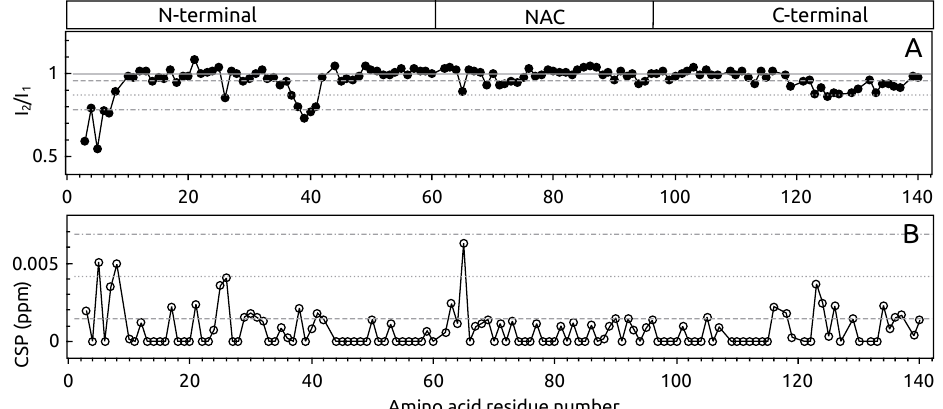
Figure 2. ( A ) Intensity and ( B ) chemical shift perturbation (CSP) of α -syn after addition of S100A9 at 10°C. Intensity change expressed as a ratio of α -syn intensities in the presence (I 2 ) and the absence (I 1 ) of S100A9. Horizontal gray lines: solid— starting point (no change of intensity), dashed—the average, dotted—average including standard deviation (STD), and dot dash—average including two STD of the signal intensity or chemical shift change. The structure segments of α -syn indicated above: N-terminal, Non-Amyloid beta Component (NAC) and C-terminal. Protein solution: 50 µM 15 N α -syn, 0 µM or 500 µM S100A9, 25 mM HEPES, 100 mM NaCl, 5mM DTT, 5 mM CaCl 2 , 5% D 2 O, 0.02% sodium azide, pH